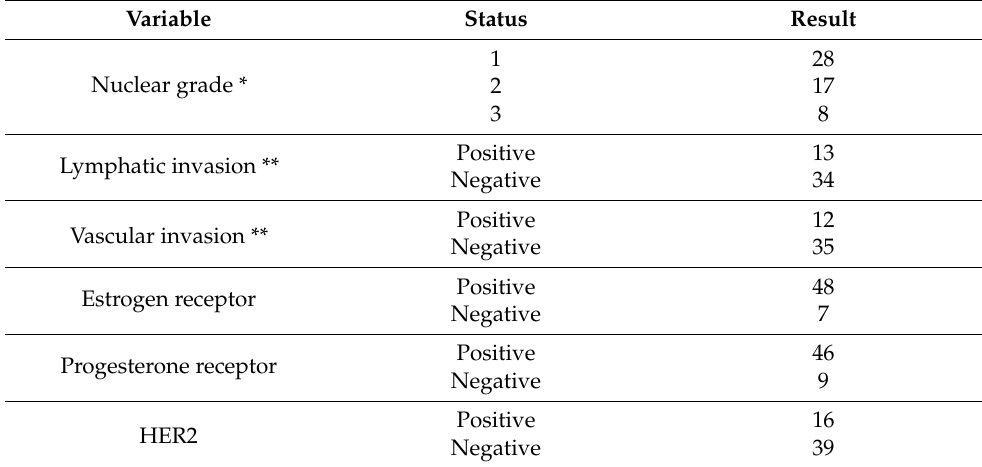
Table 1. Pathology results of the 55 breast